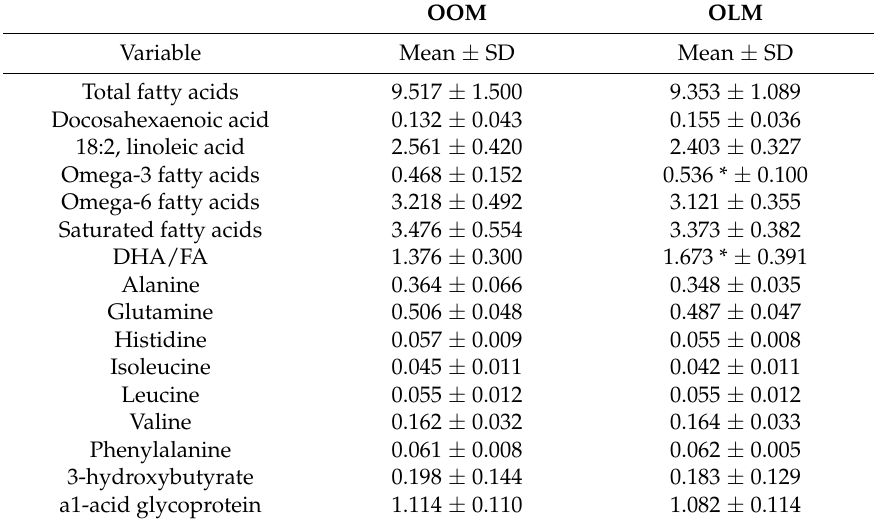
Table 2. Circulating metabolites that are associated with insulin resistance and glucose metabolism.